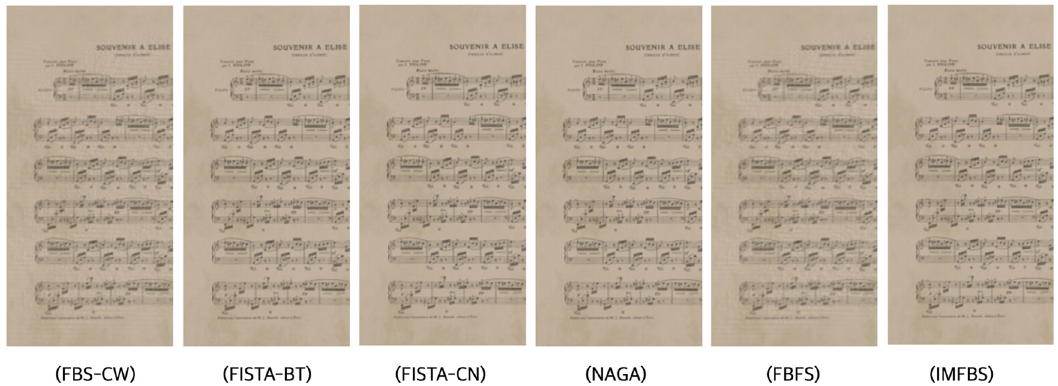
Figure 5: The restored images by BM - 2.3 for FBS - CW ( PSNR:33.3404, SSIM:0.9549 ) , FISTA - BT ( PSNR:44.9116, SSIM:0.9943 ) , FISTA - CN ( PSNR:46.2742, SSIM:0.9957 ) , NAGA ( PSNR:45.8330, SSIM:0.9953 ) , FBFS ( PSNR:31.7652, SSIM:0.9412 ) , and IMFBS ( PSNR:48.6282, SSIM:0.9974 ) , respectively.